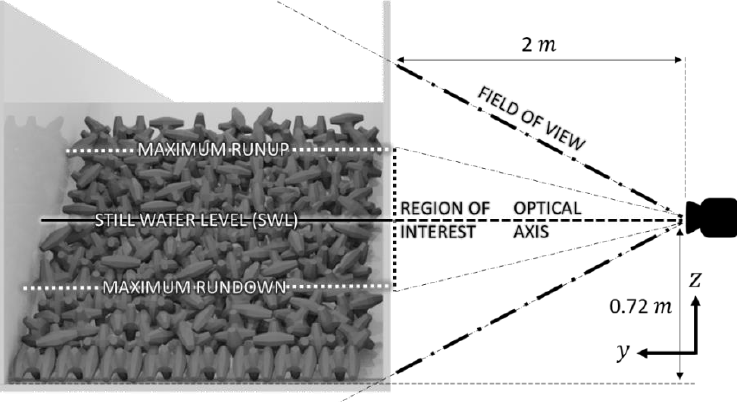
Figure 2. Diagram of the camera setup.